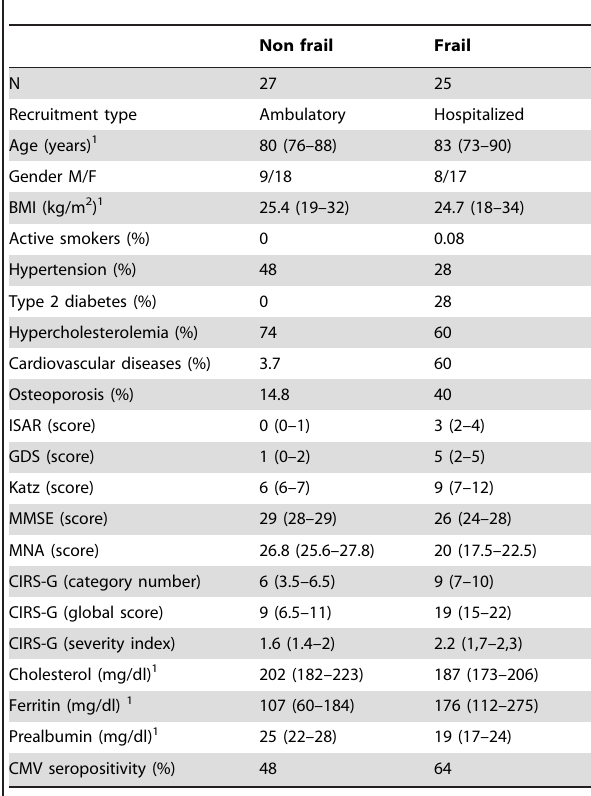
Table 2. Demographic, geriatric and biochemical characteristics of frail and non frail subjects . 75 years of